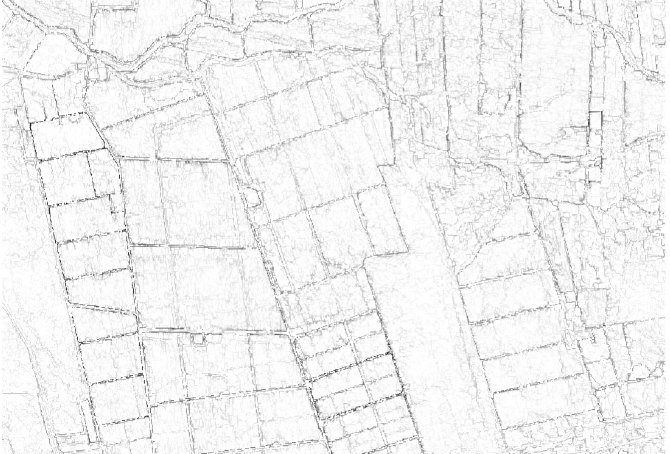
Figure 6. Result of applying the ultrametric contour map (UCM) algorithm to the average of the three